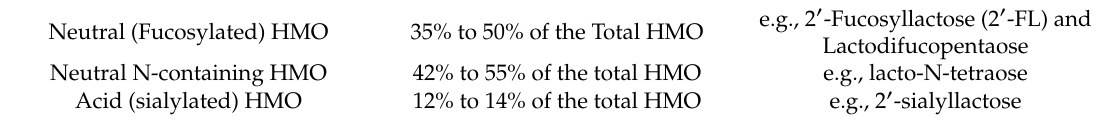
Table 1. Human milk contains three major HMO types [13].